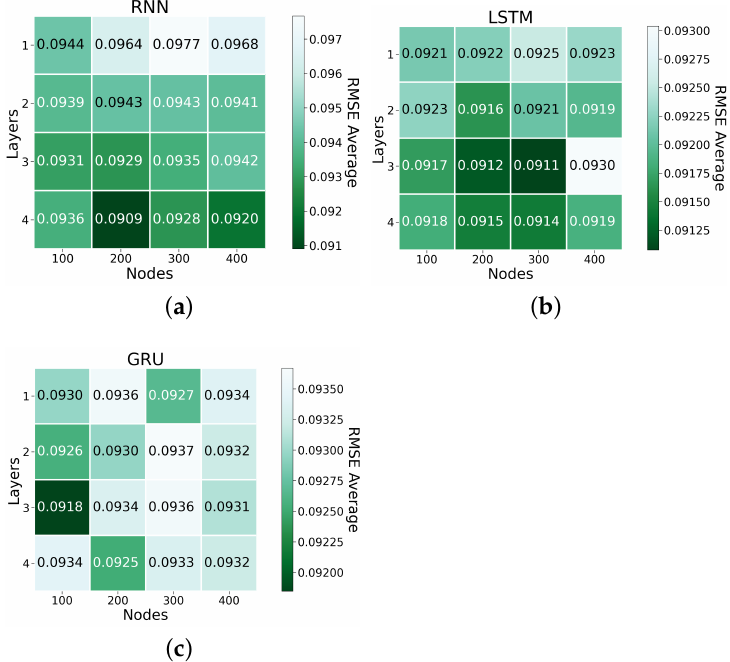
Figure 8. RMSE grid search result for ( a ) RNN; ( b ) LSTM; and ( c ) GRU.